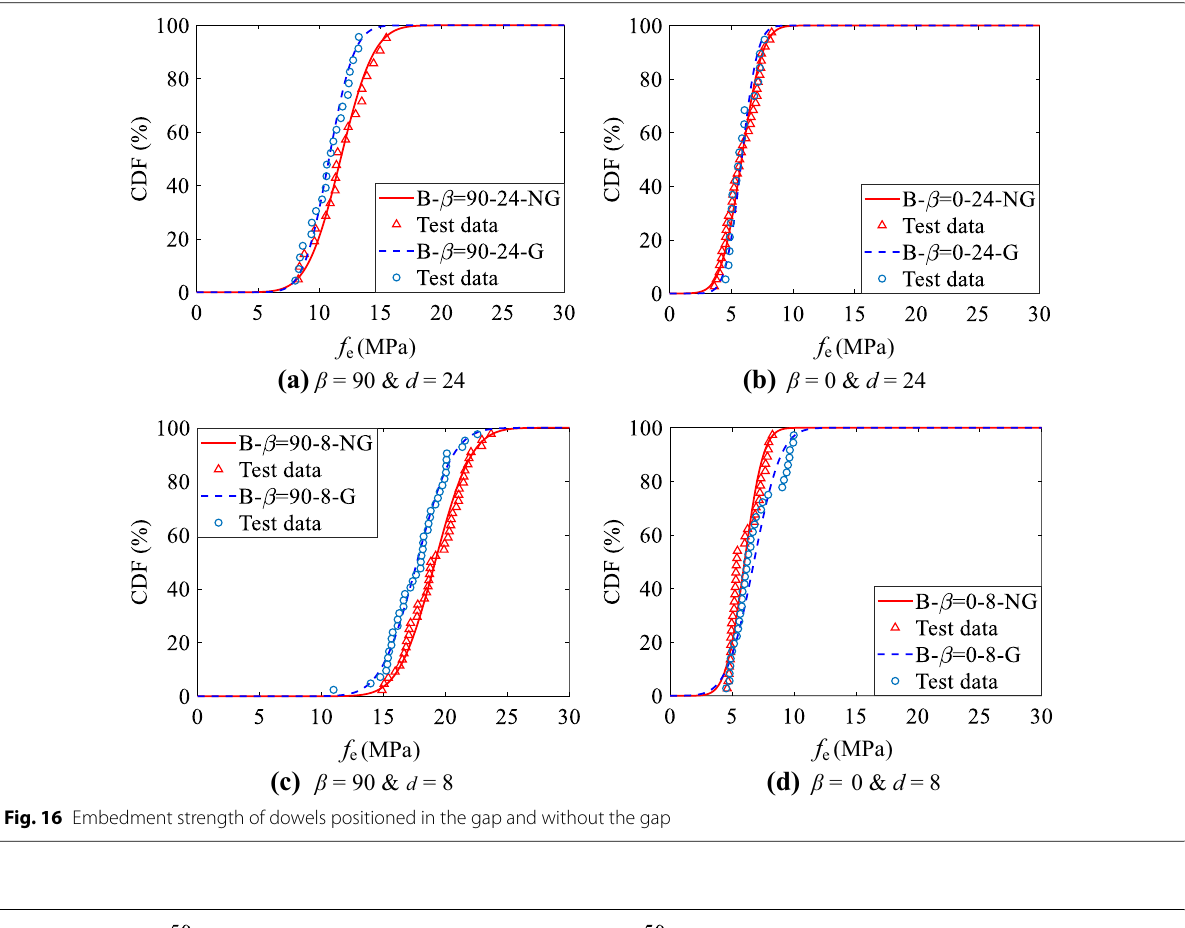
Fig. 16 Embedment strength of dowels positioned in the gap and without the gap